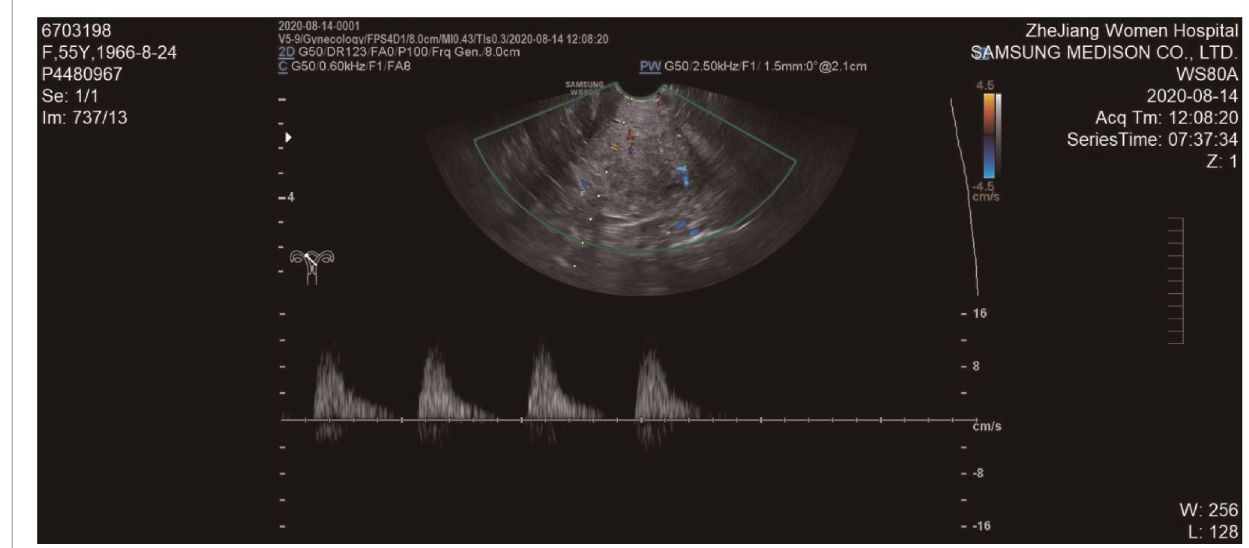
FIGURE 1 | Ultrasonography showed echogenicity of thickened myometrium, suggesting